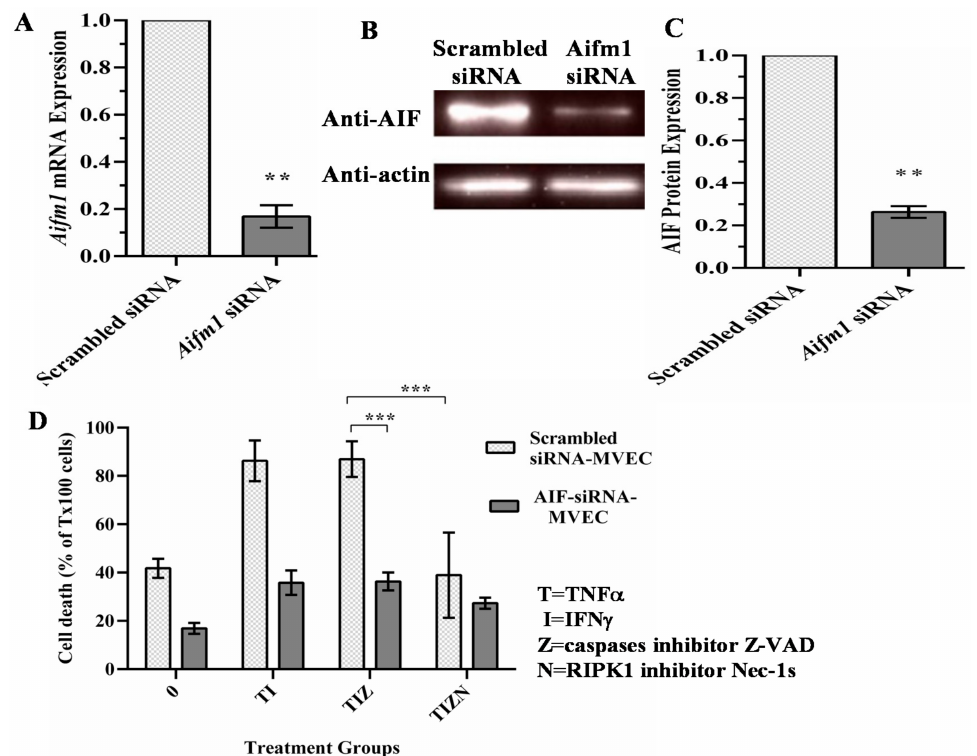
Figure 3. AIF silencing prevents necroptosis in endothelial cells. ( A ) siRNA-induced silencing of AIF was confirmed by qPCR. β -actin was used as an endogenous control for the gene expression analysis. Data at 48 h post-transfection are shown as the mean ± SD and representative of 3 independent qPCR experiments. n = 3; ** p ≤ 0.01; Student’s t -test. ( B ) The reduction in the protein expression of AIF-silenced cells was confirmed by a Western blot analysis at 72 h post-transfection. β -actin was used as a loading control. ( C ) The reduction in the level of AIF protein expression was measured in 3 independent experiments. n = 3; ** p ≤ 0.01; Student’s t -test. ( D ) Scrambled siRNA-transfected and AIF-silenced MVECs were harvested 48 h post-transfection and subjected to the in vitro simulating IRI treatment, as in Figure 1. Data are shown as the mean ± SD and representative of 3 independent experiments. *** p ≤ 0.001; 2-way ANOVA and Tukey’s multiple comparisons